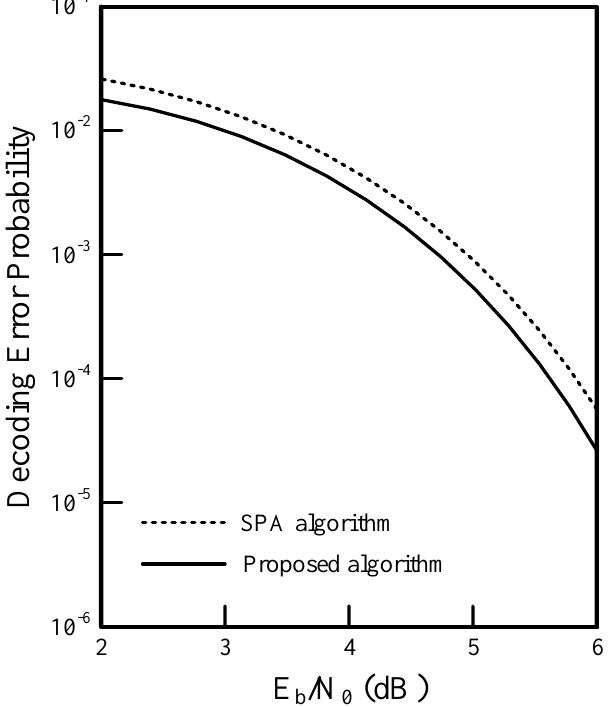
Figure 2. Error probability of Golay (23,